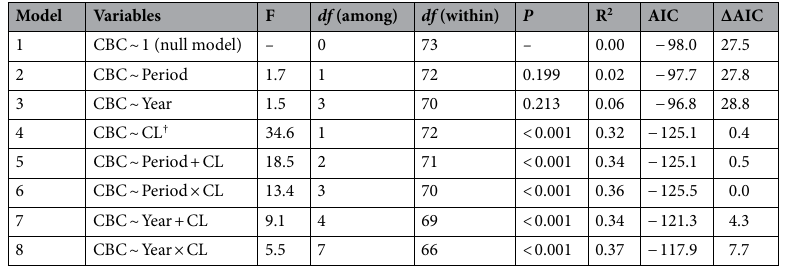
Table 3. Linear model selection results based on minimization of Akaike’s information criterion (AIC) for southern right whale calf body condition (CBC). CL calf relative length (% maternal length). † The most parsimonious model (Model 4).